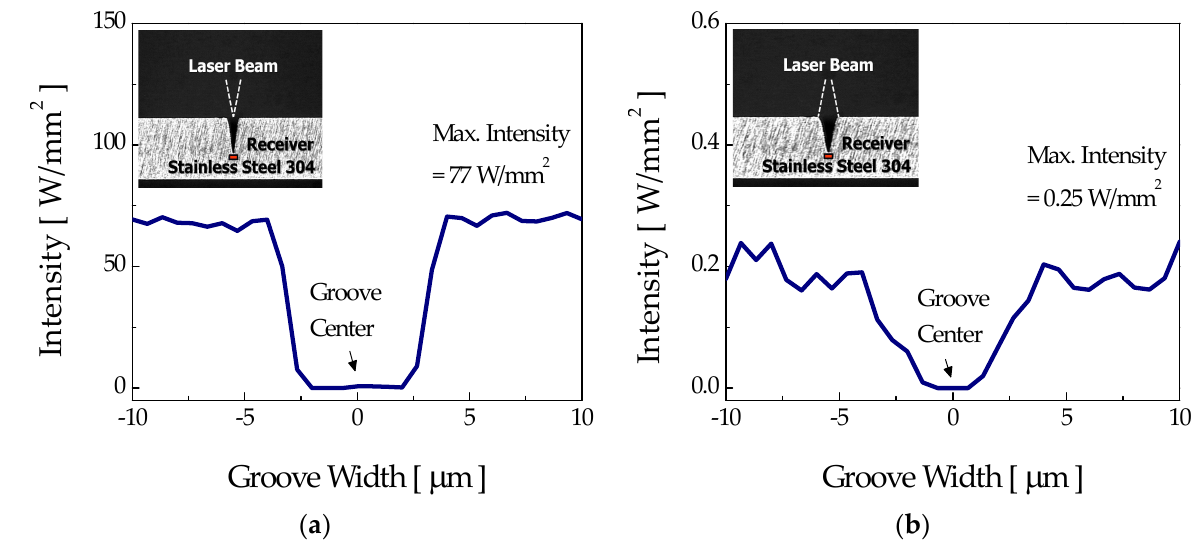
Figure 11. Bottom intensity distributions of the fully developed V-groove which appeared in the ( a ) focusing mode and ( b ) diverging mode.